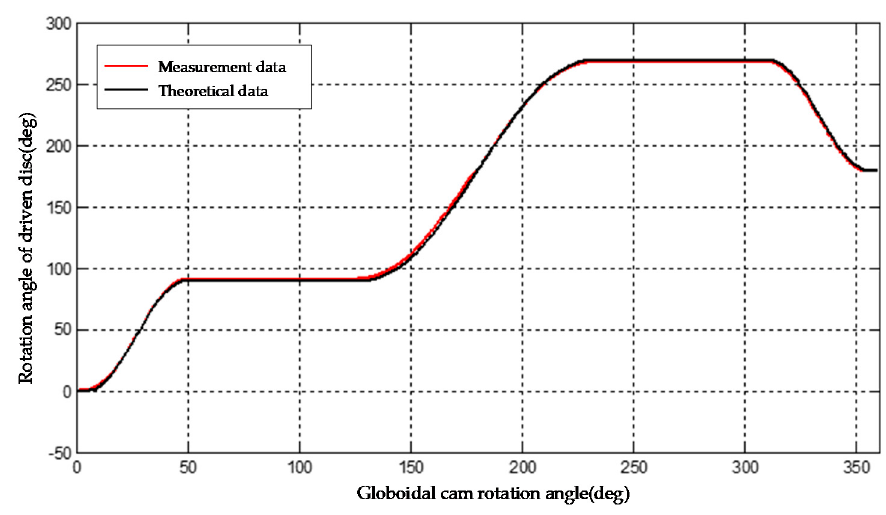
Figure 11. The transmission curve of CAM II.